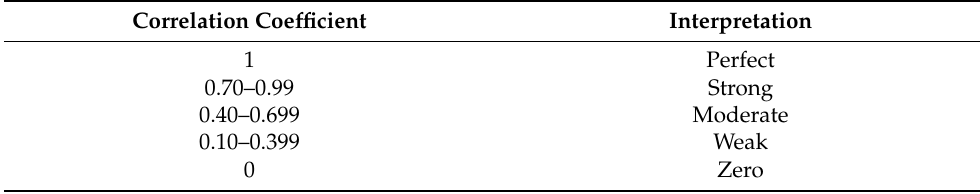
Table 1. Interpretation of correlation coefficient strength.